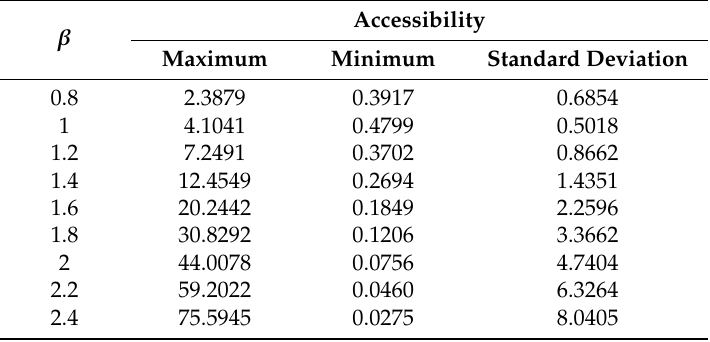
Table 1. Descriptive statistics of accessibility to the optimized